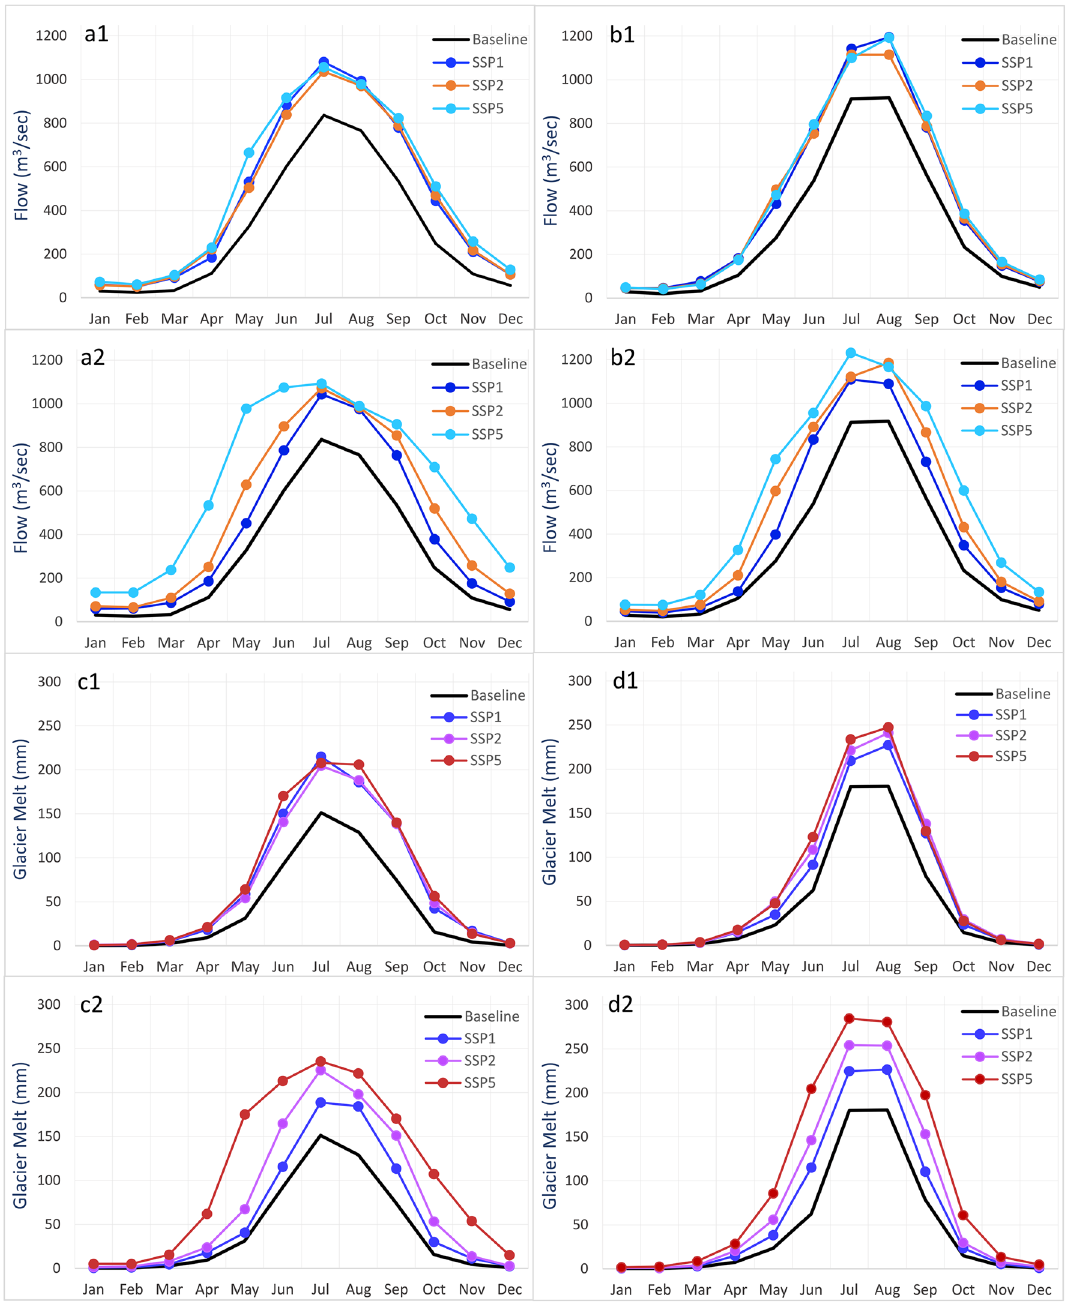
Figure 4. Mean monthly simulated future flow (Qsim) and glacier melt (GM) relative to the baseline; ( a1 ) ECE3-Qsim for mid-century, ( a2 ) ECE3-Qsim for end-century, ( b1 ) ESM-Qsim for mid-century, ( b2 ) ESM- Qsim for end-century, ( c1 ) ECE3-GM based mid-century, ( c2 ) ECE3-GM based end-century, ( d1 ) ESM-GM based mid-century and ( d2 ) ESM-GM based significantly in all warming scenarios and GCMs. Also, relative to the baseline, the period of snow coverage will be reduced. For instance, the ECE3 based SSP5-end-century scenario indicates no snow in the basin in July and August. The SCA differences from the baseline period to the future are minimum for winter and maximum for summer months. These trends are consistent for both GCMs with slightly higher SCA in the ESM based simu- lations. The changes in SWE from baseline indicated the winter months would have more SWE relative to the baseline period. However, the mean monthly SWE (Table 4) will differ significantly in both GCMs.